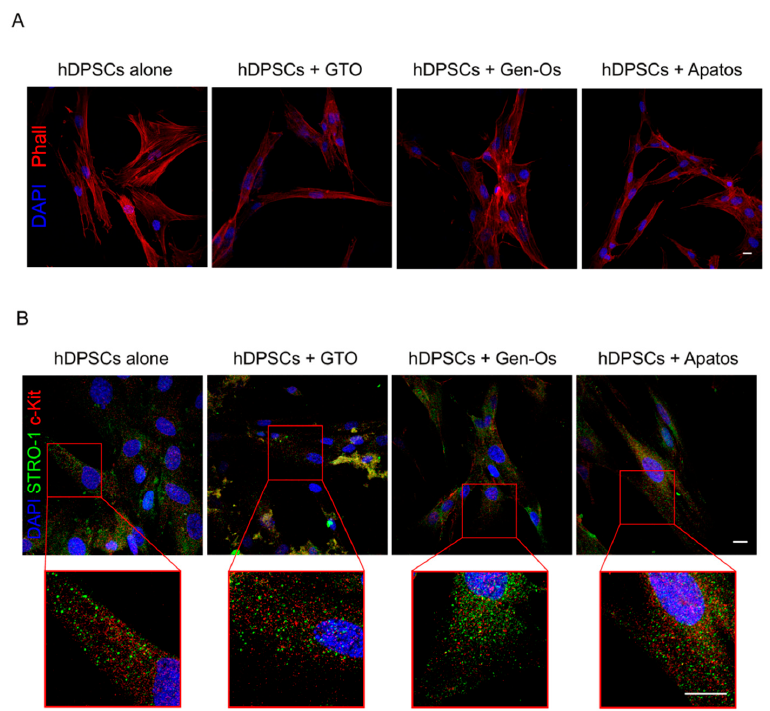
Figure 2. Evaluation of phalloidin and stemness markers on immunoselected hDPSCs. ( A ) hDPSCs morphology are evaluated by immunofluorescence analysis of phalloidin (PHA)-stained cells, after 48 h of BSBs treatment. Nuclei are counterstained with DAPI. Scale bar = 10 µ m. ( B ) Evaluation by immunofluorescence analysis of stemness markers STRO-1 (green) and c-Kit (red), after 48 h of BSBs treatment. High-magnification images showing markers localization are reported in red squares. Nuclei are counterstained with DAPI. Scale bar = 10 μ m.